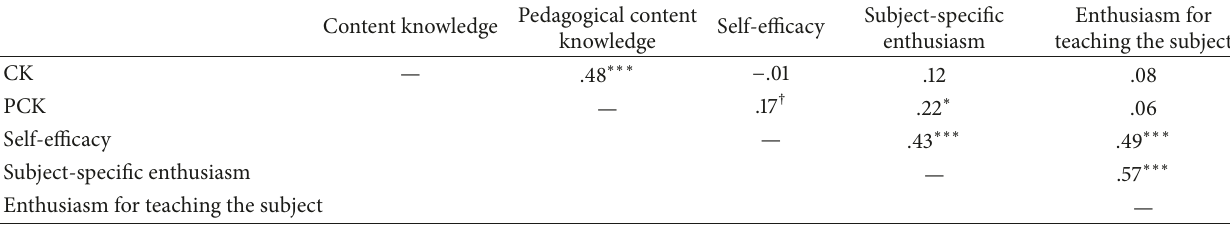
Table 5: Latent correlation matrix for self-efficacy as well as enthusiasm and content-related professional